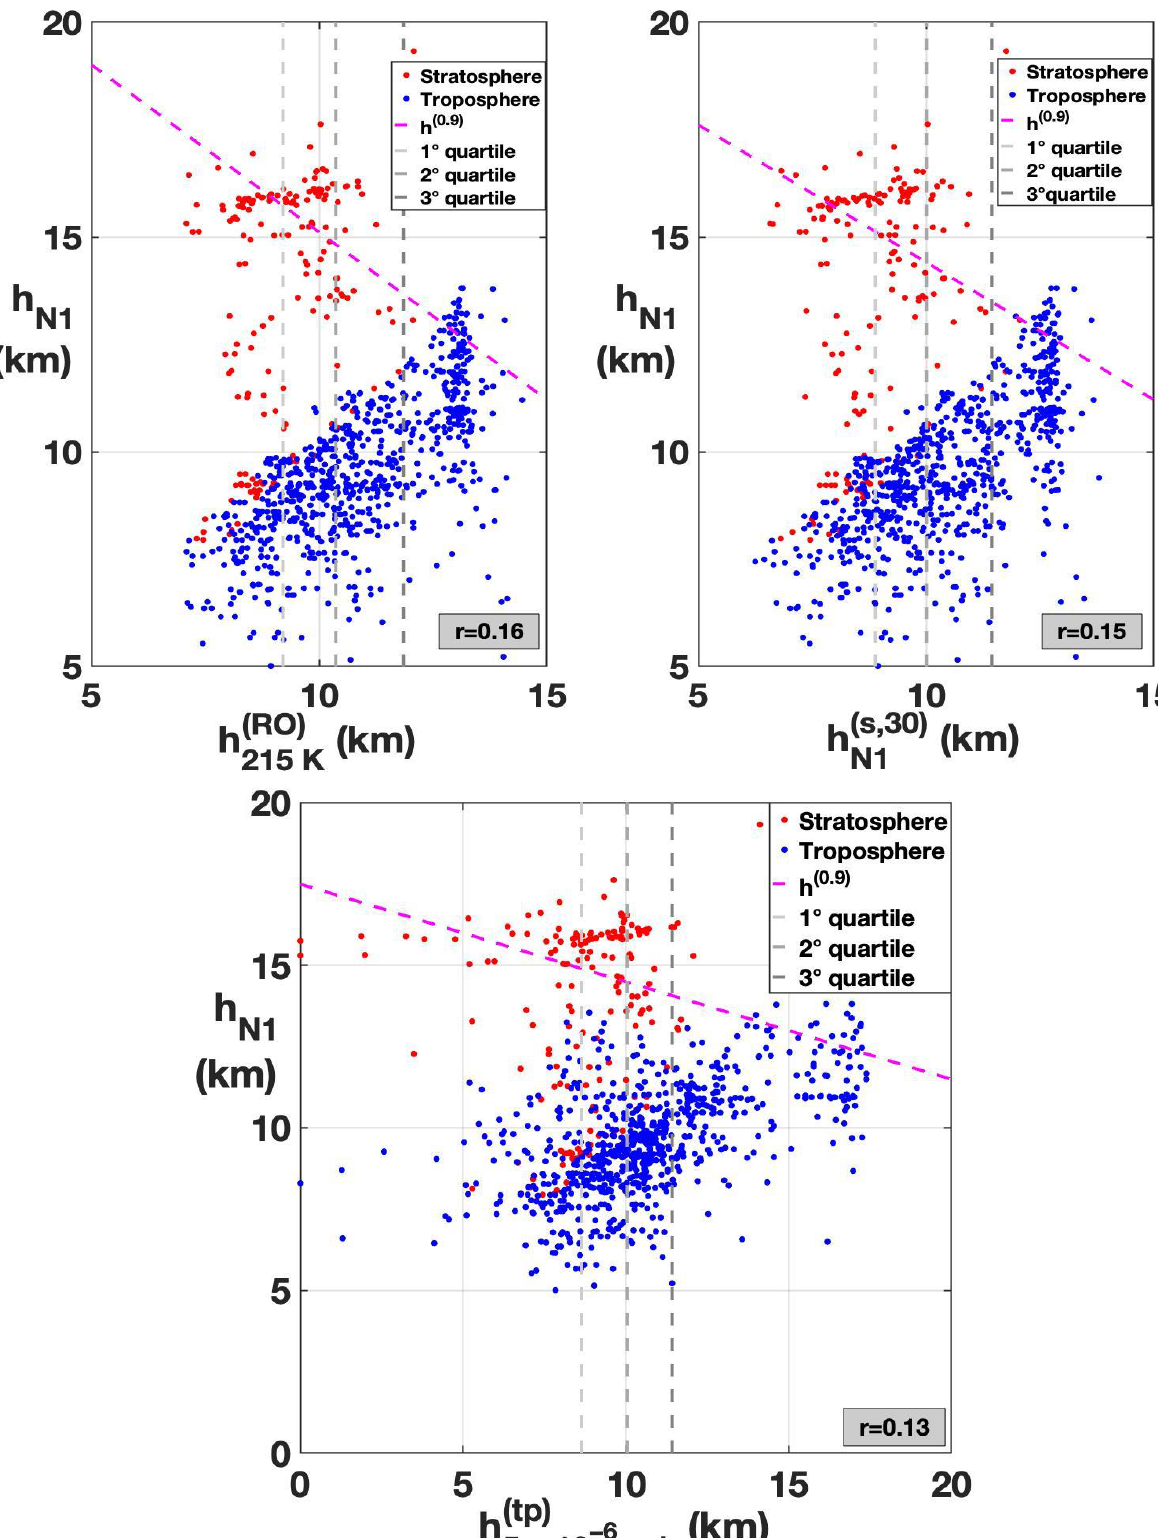
( RO ) ( top left ), 215 K 𝐾(𝑅𝑂) ( top left ), ℎ 𝑁1(𝑠,30) 215